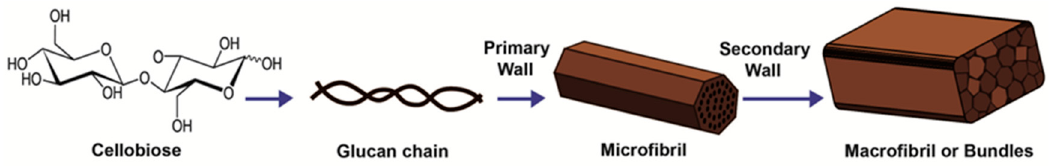
Figure 3. Glucose residues polymerized into individual chain and further assemble into microfibrils and macrofibrils or bundles (redrawn from [9]).